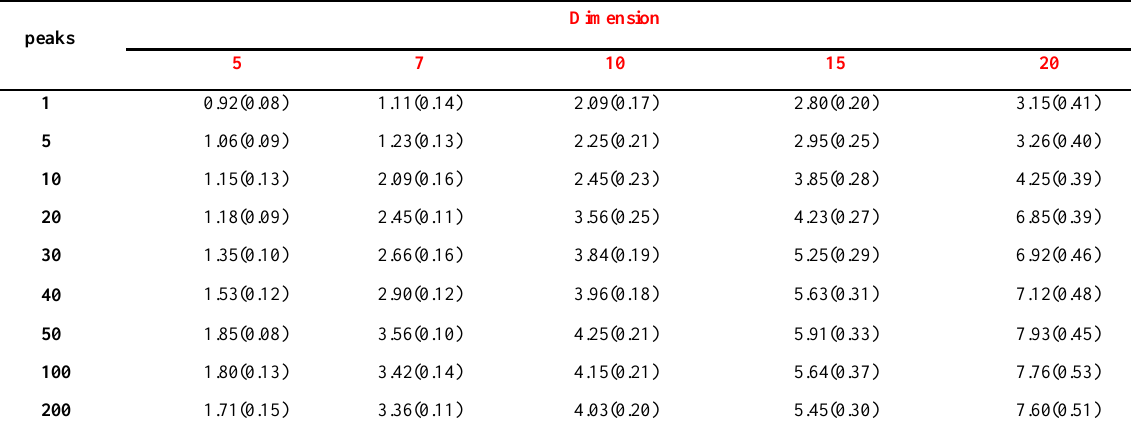
Table 7. Offline error for proposed algorithm with frequency change = 5000 and different peaks and different dimensions and shift length =